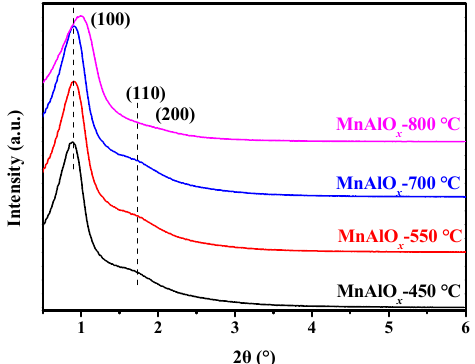
Figure 3. Small-angle patterns of mesoporous MnAlO x -T catalysts.